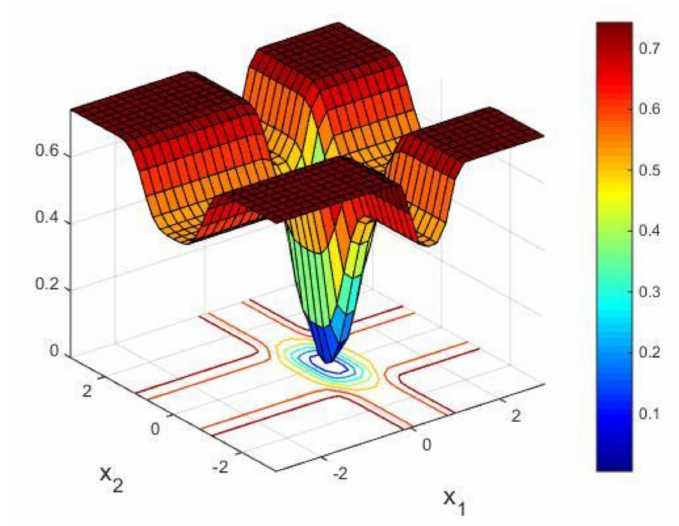
Figure 2. Precipitation and temperature